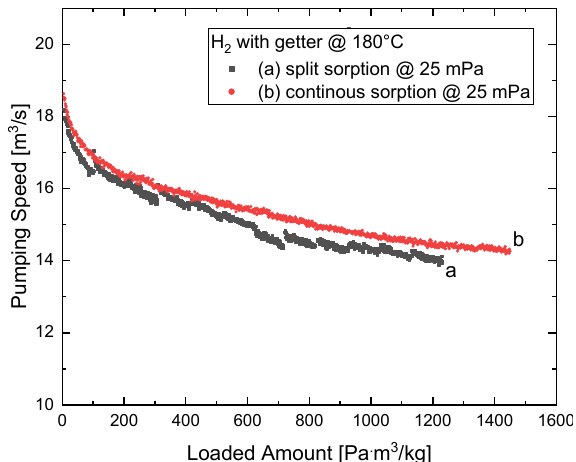
Figure 15. Pumping speed comparison for the continuous and split dosage (1 h sorption, 1 h break) of H 2 with ZAO ® at 180 °C.